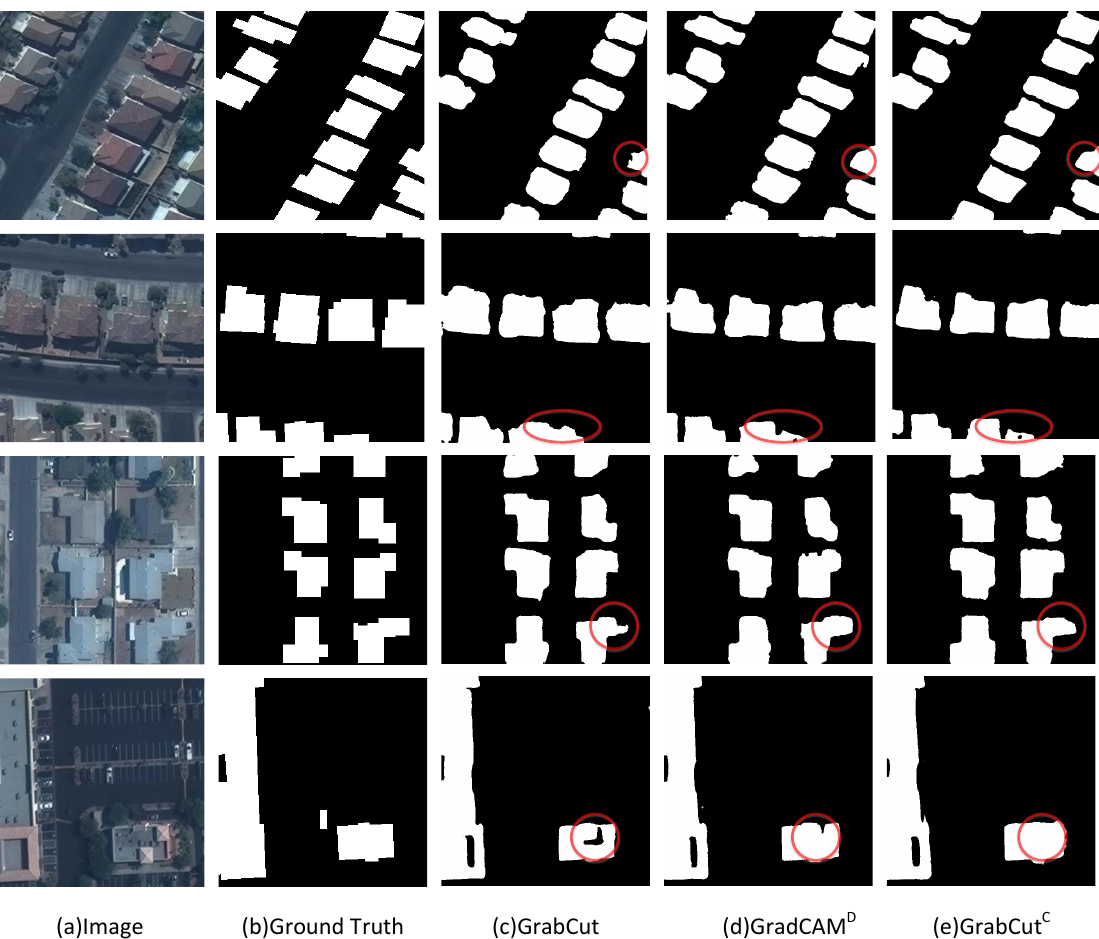
Figure 7. Examples of segmentation results of our method on mapping challenge dataset. ( a ) Image.